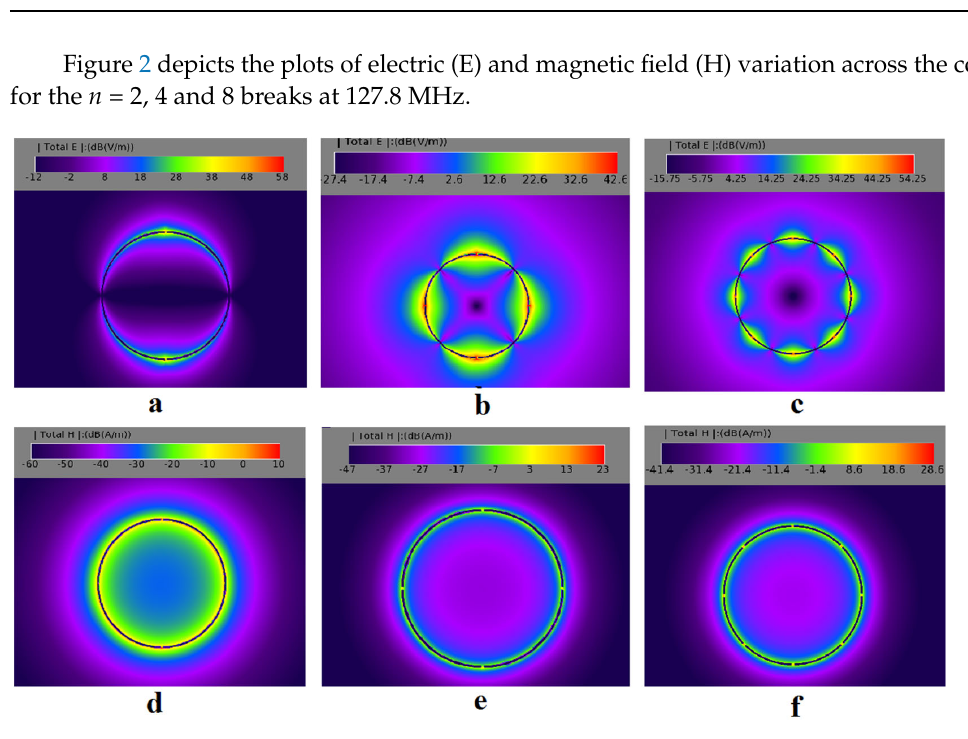
Figure 2. The field patterns for the different coil segmentation at 127.8 MHz: E field for ( a ) n = 2; ( b ) n = 4; ( c ) n = 8; H field for ( d ) n = 2; ( e ) n = 4; ( f ) n = 8.